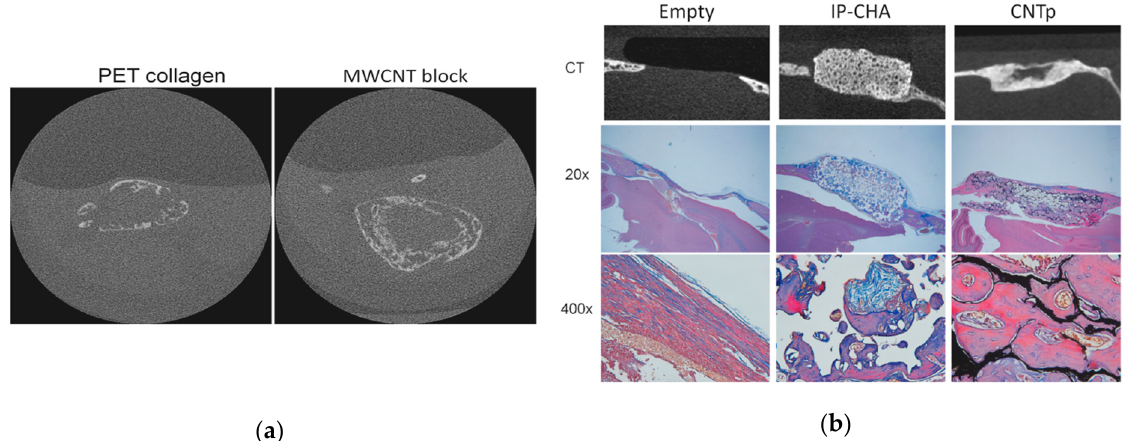
Figure 5. ( a ) The microcomputed tomography ( µ CT) image of ectopic bone formed at three weeks after subcutaneous implantation of sca ff old with recombinant human bone morphogenetic protein-2 (rhBMP-2) in a mouse model. Ectopic bone formation comparable to that of the MWCNT block was found in the polyethylene terephthalate (PET)-reinforced collagen sca ff old. Image is modified from a study by Tanaka et al. [74]. ( b ) In a mouse calvarial defect model, critical size bone defects were repaired with new bone in both the IP-CHA and CNTp groups. Image is modified from a study by Tanaka et al. [51].